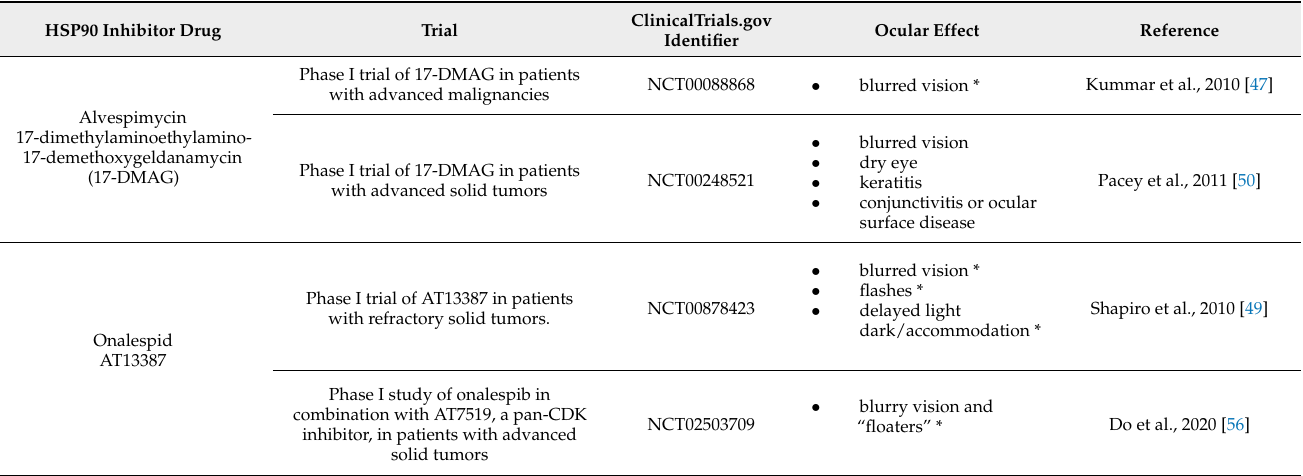
Table 2. List of Hsp90 inhibitors used in clinical trials in oncology and their ocular effects. * The observed ocular effects were transient or resolved after treatment